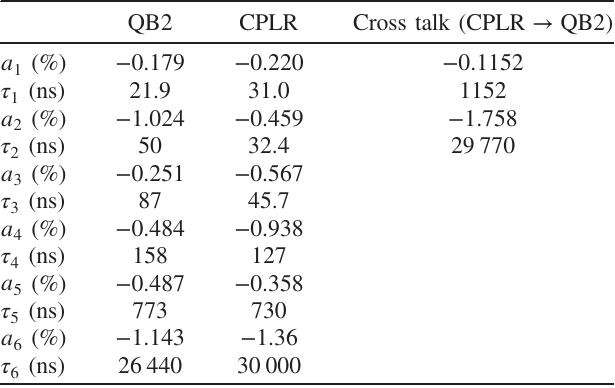
TABLE IV. Summary of the fitted flux-transient